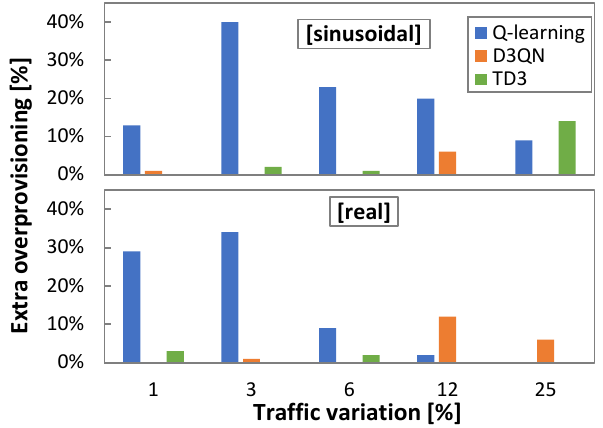
Figure 12. Relative extra overprovisioning. Table 3. Additional overprovisioning when fixing ρ